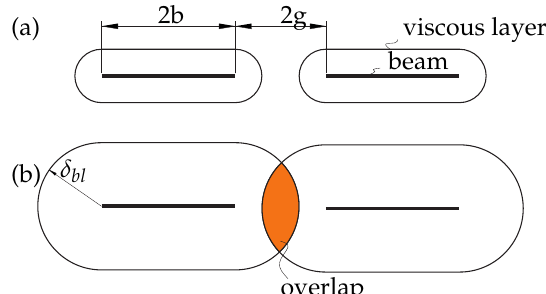
Figure 12. Localized boundary layers for higher Reynolds number ( a ) Re = 100 and ( b ) overlapping boundary layers for lower Reynolds number Re =